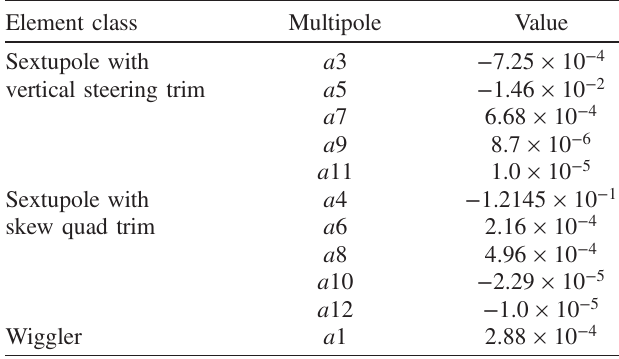
TABLE IX. Multipoles used in RING _ MA 2 studies of CesrTA lattice. Sextupole multipoles are systematic and therefore iden- tical at all sextupoles, whereas the wiggler a 1 multipole is rms of the applied